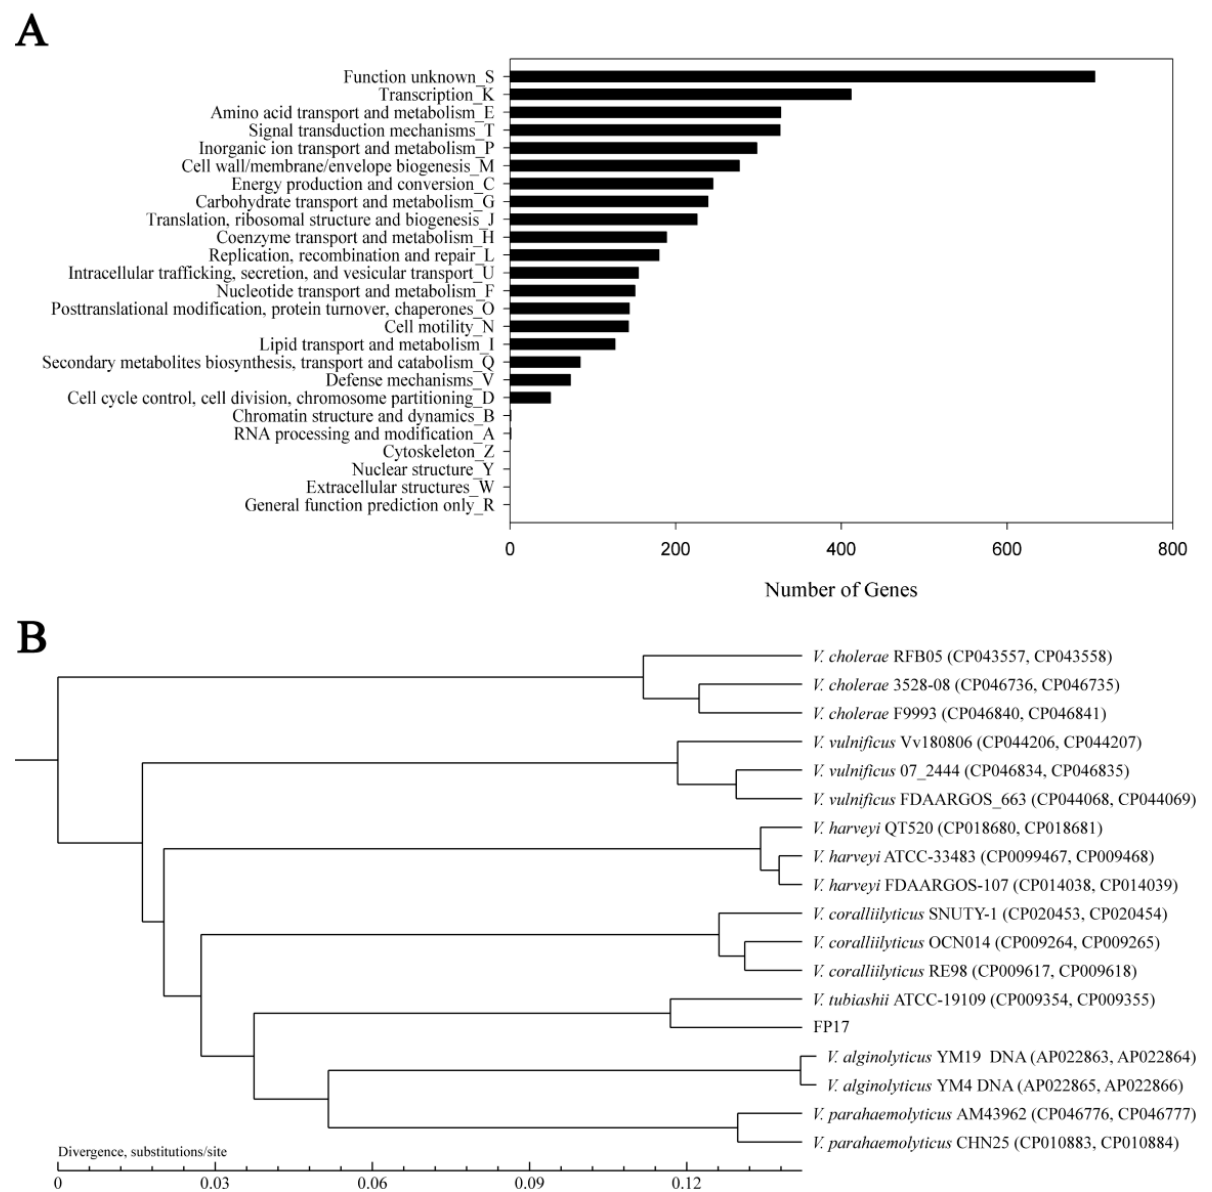
Figure 3. ( A ) Functional categorization of V. tubiashii FP17 based on the COG database. ( B ) The phylogenetic tree of V. tubiashii FP17 with closely related vibrio species according to the ANI